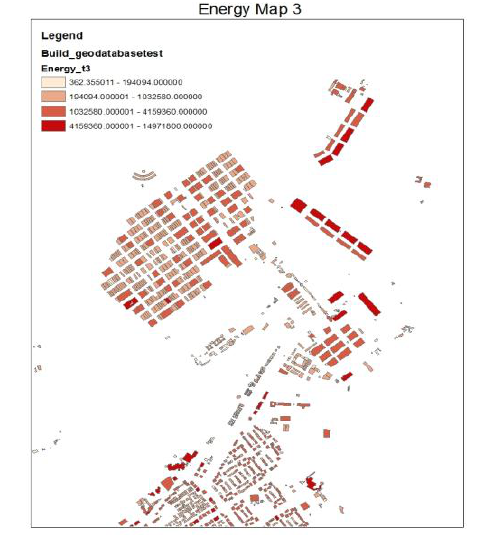
Figure 1 Energy Map of the Test